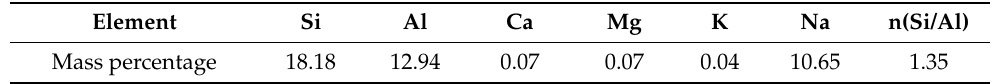
Table 1. Element content of NaX zeolite (wt